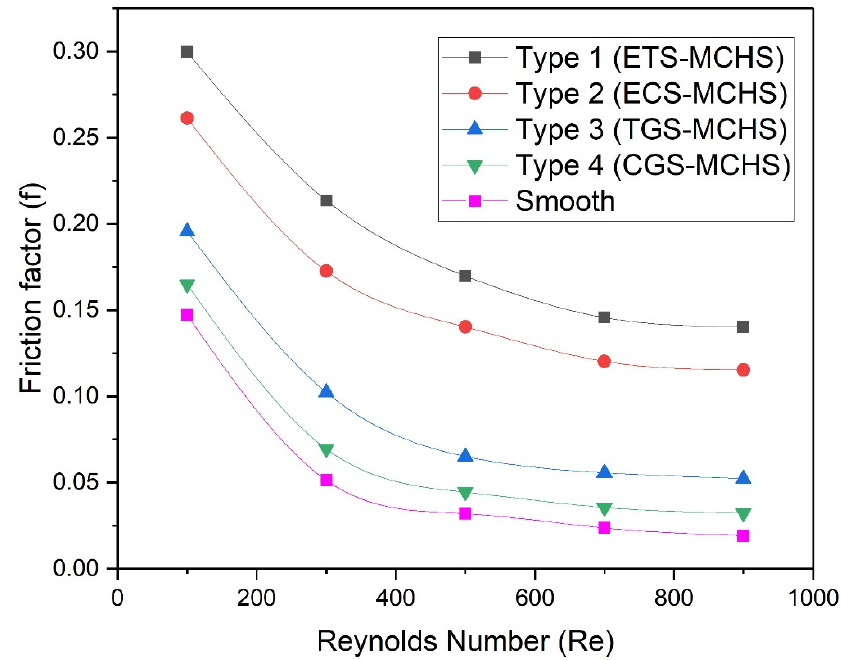
Figure 11. Plots of friction factor with Reynolds numbers for different angles.